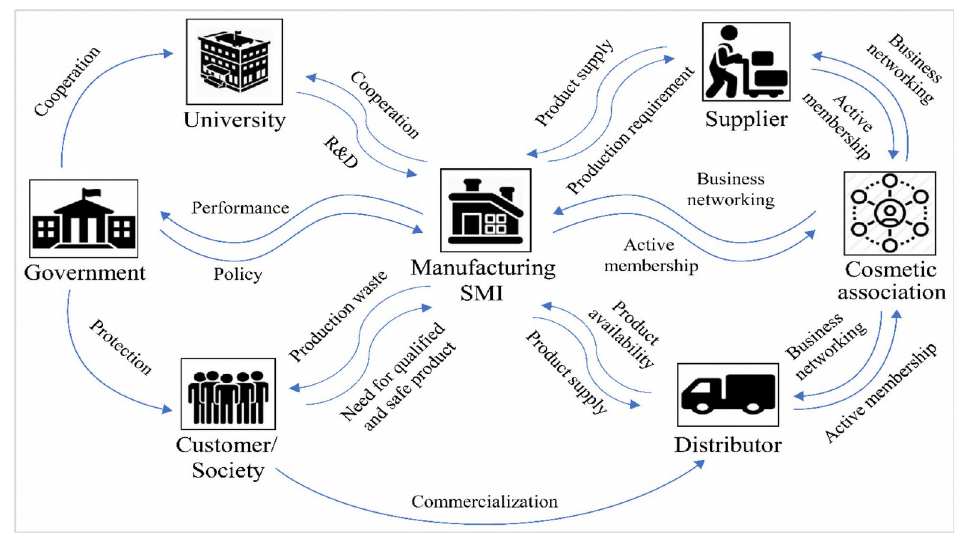
Figure 2. Dynamic relationship between cosmetics SMI